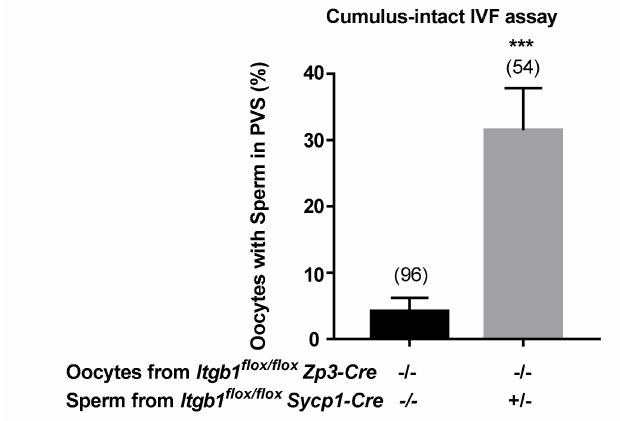
Figure 4. Sperm accumulation in oocytes’ perivitelline space (PVS) after control oocytes ( Zp3-Cre − / − Itgb1 flox / flox ) insemination with sperm from KD ( Sycp1-Cre + / − Itgb1 flox / flox ) or control ( Sycp1-Cre − / − Itgb1 flox / flox ) males. After cumulus-intact IVF assays, was reported the percentage of PVS containing-oocytes (mean ± s.e.m.) that showed high and significant di ff erence when comparing the two groups (*** p < 0.0001). The numbers in parentheses represent the number of used oocytes in each